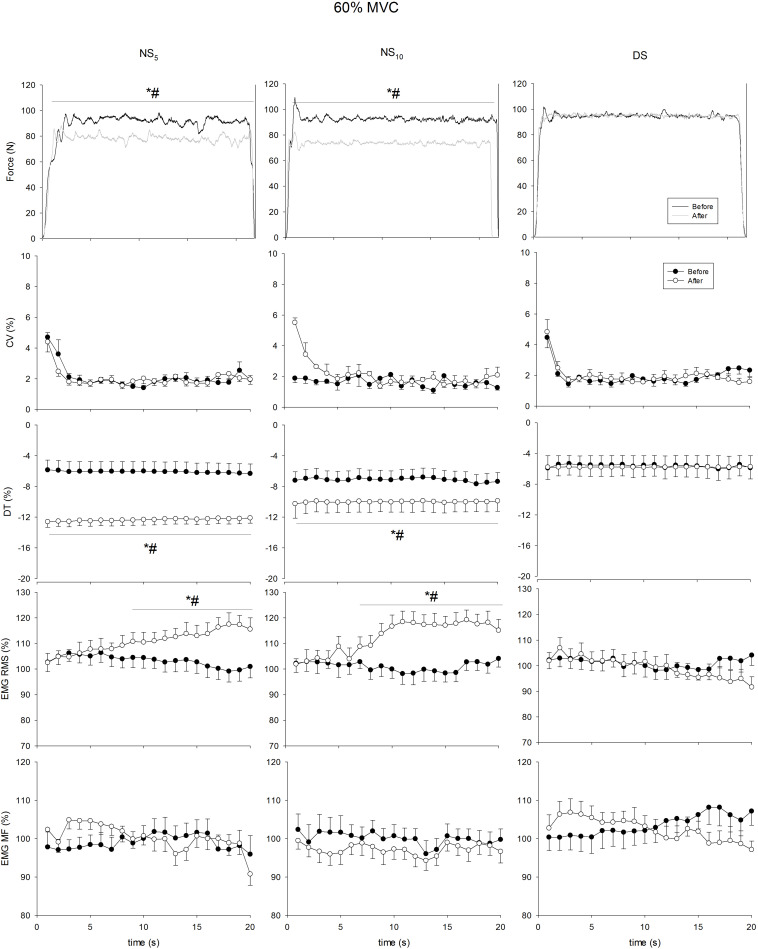
Coefficient of variation (CV), distance to target (DT), surface electromyogram root mean square (sEMG RMS), and mean frequency (sEMG MF) at 60% of maximum voluntary contraction (MVC) force maintained for 20 s at the beginning (pre, solid circle) and at the end (post, blank circle) of the shift cycle in the three groups. NS5, 5-day night shift; NS10, 10-day night shift; DS, day/swing shift. *p < 0.05 post vs. pre; #p < 0.05 NS5 or NS10 vs. DS.